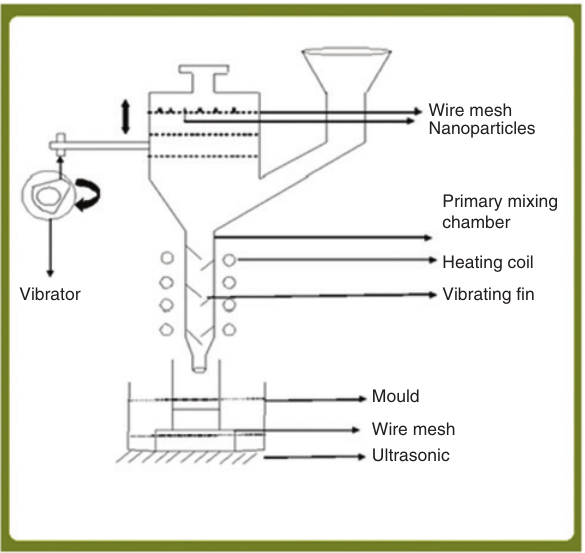
Figure 1 Schematic diagram of ultrasonic full cavitations experi- mental setup.